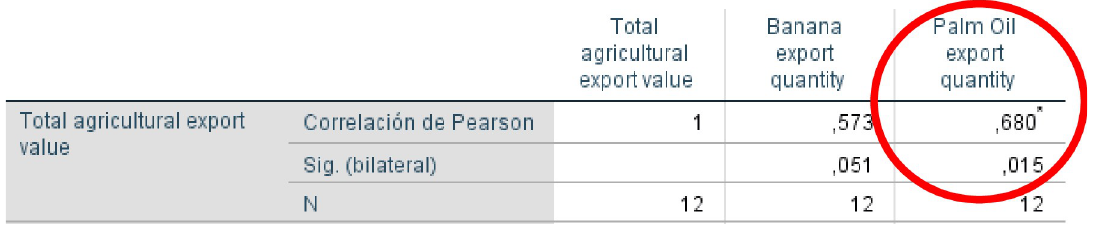
Fig 7. Correlation of agriculture commodities production. Source: Own calculations.